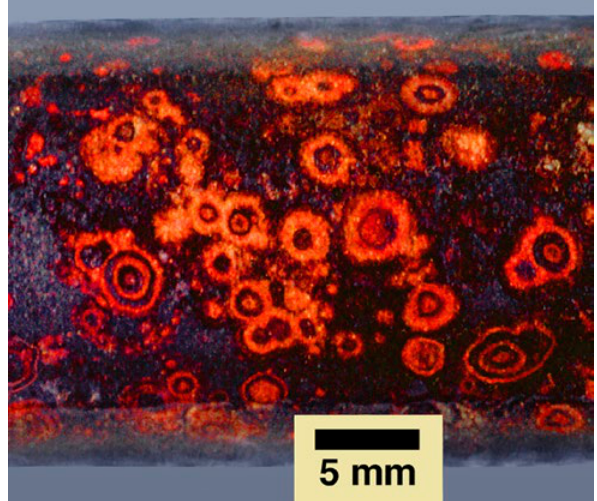
Figure 66. Jaspoidal chert-magnetite oolites are preserved in part of the Peko Mine main lode at Tennant Creek, NT. This section of the ore breccia pipe has not been disrupted by later re-mobilisation. Original colloform textures are often preserved in large rafts, or near the lode wall where later thixotropic re-liquefaction and intru- sion of the ore pipe slurry has not affected the whole semi-consoli- dated mineral